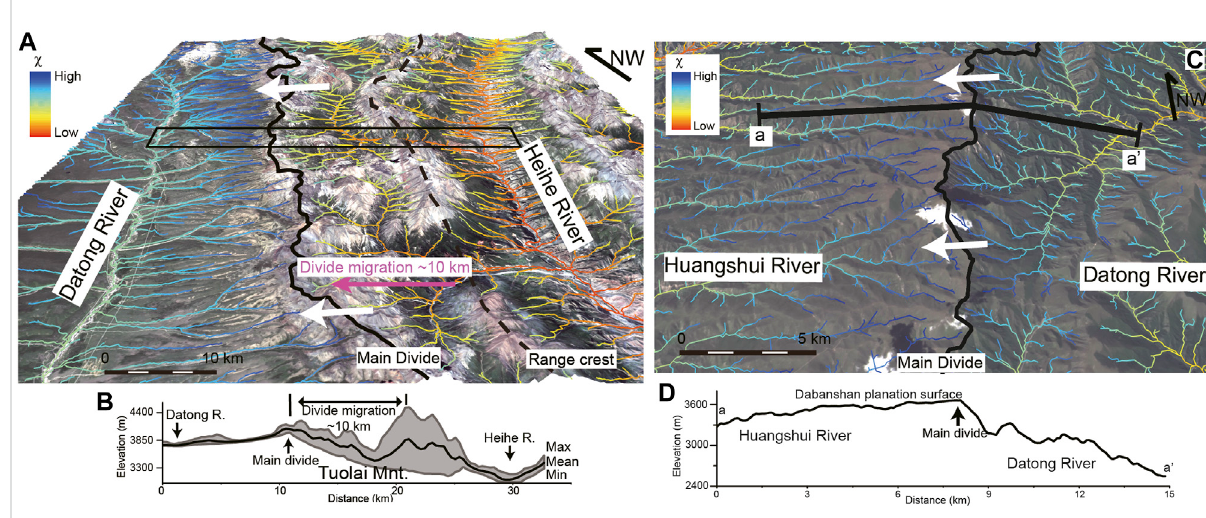
FIGURE 4 (A) : χ -map of the upper Datong River and Heihe River. The black line indicates the main divide, and the black dotted line indicates the range crest. The black box shows the position of the swath topographic pro fi le. White arrows indicate the predicted divide migration direction. (B) : Swath topographic pro fi le with 3 km width across Tuolai Mountain. Vertical arrows mark the Datong River, Heihe River and the main divide; each pro fi le shows the maximum, mean, and minimum elevations, respectively, and the shaded area marks the local relief. (C) : χ -map of the lower Datong RiverandHuangshuiRiver.Theblacklineindicatesthemaindivide.Linea – a ’ showsthepositionofthetopographicpro fi le.Whitearrowsindicatethe predicted divide migration direction. (D) : Topographic pro fi le across Daban Mountain. Vertical arrows mark the main divide.